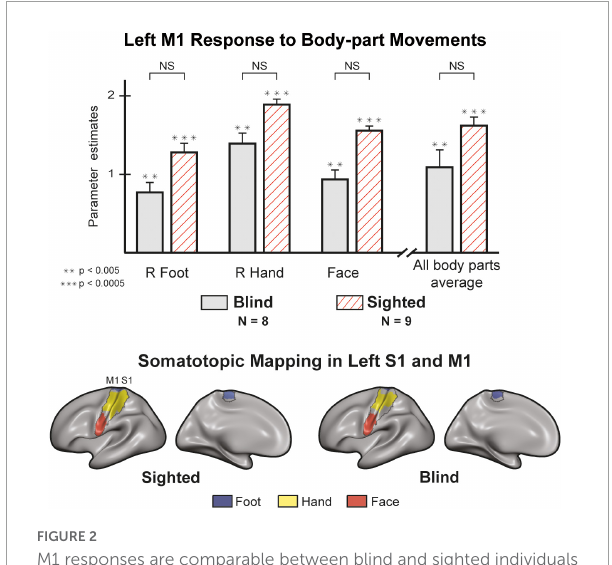
FIGURE2 M1 responses are comparable between blind and sighted individuals [random effects General Linear Model (GLM)]. There were no significant group differences in M1 activity (left hemisphere) for all unilateral and face movements ( Supplementary Table 5 ). Regions of Interest (ROI) analysis of right M1 produced similar results ( Supplementary Figure 7 ). The sighted and blind groups show similar somatotopic organization in S1 and M1. We created the maps by contrasting each condition with all others. We then plotted and colored all statistically significant vertices ( p < 0.05, corrected). The results on the left hemisphere represent the response to right hand, right foot, and face movements. We found similar results in the right hemisphere for contralateral effectors ( Supplementary Figure 5 ). Error bars are for the standard error. Large asterisks indicate between-group significance, small asterisks indicate within-group significance against the baseline. NS,